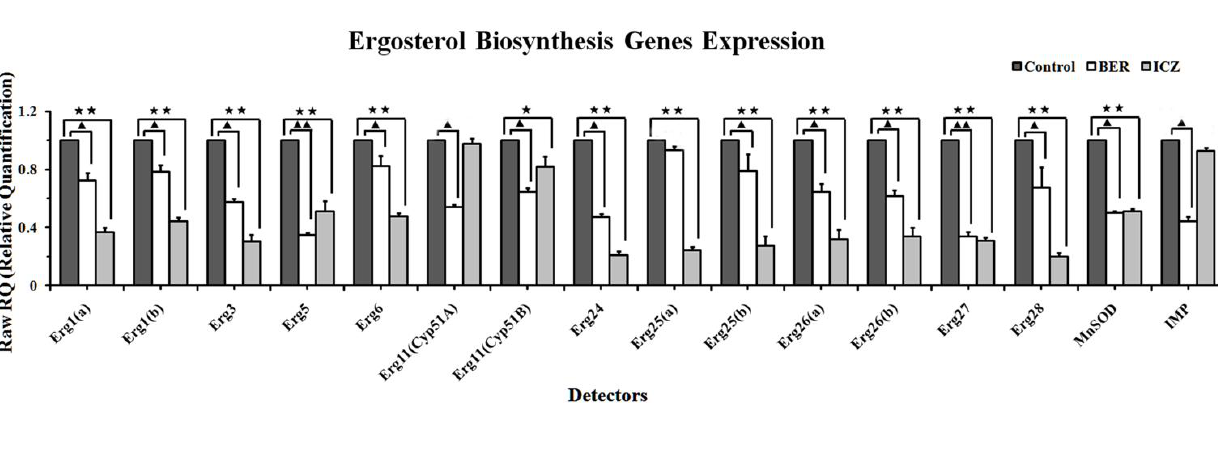
Figure 7. Comparison of the changes in expression of ergosterol biosynthesis pathway gene, determined by real-time PCR approaches. Student’s t -test was used to determine whether fold changes in gene expression induced by BER or induced by ICZ were different < 0.05), ★ ( P < 0.05) from untreated control. Significant differences are denoted with ▲ ( P BER ICZ and ▲▲ ( P < 0.01), ★★ ( P < 0.01). The fold expression in A. fumigatus treated BER ICZ